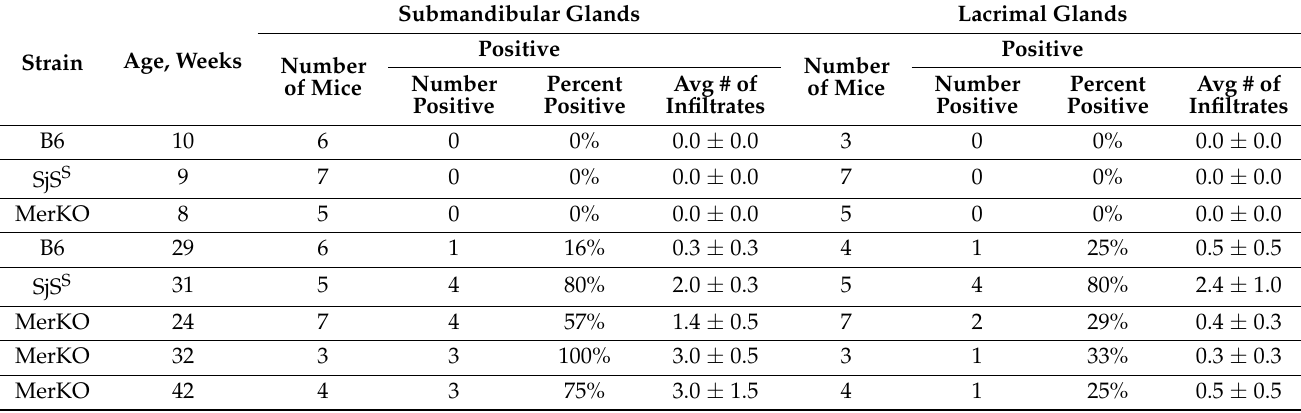
Table 1. MerKO mice developed SMG infiltration that increases with age and limited LG involvement. Paraffin-embedded SMG and LG from B6, SjS S , and MerKO mice were stained for Hematoxylin and Eosin and observed under a light microscope at 200 × for incidence of lymphocytic infiltrates by three independent